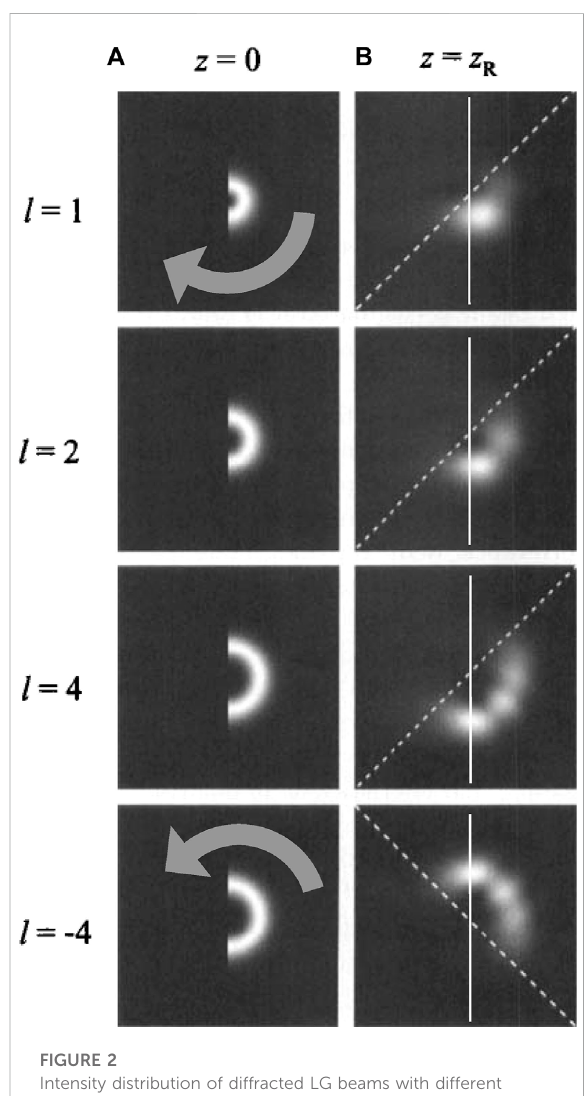
FIGURE 2 Intensity distribution of diffracted LG beams with different azimuthal indices l (beam waist coincides with the screen plane, the screen with the rectilinear vertical edge covers exactly half of theincidentbeamcrosssection)[43]: (A) immediately behind the screen and (B) at a distance z = z R behind the screen. Grey arrowsshowthedirectionoftransverseenergycirculation, dashed lines correspond to a rotation angle of 45 ° , solid vertical lines are projections of the screen edge (the shadow-area